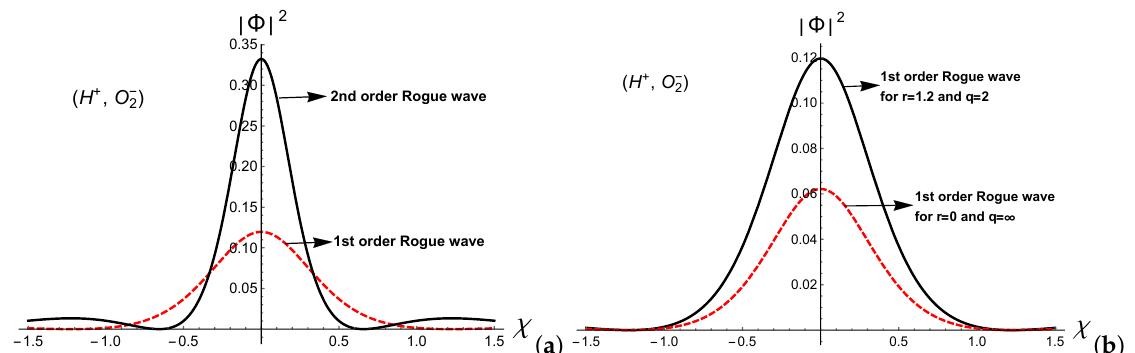
Figure 5. The amplitude of the first-and second-order IARWs with r = 1.2 and q = 2 ( a ) and the first-order IARWs amplitude obtained by non-Maxwellian ( r , q ) and Maxwellian distributed for both electrons and positrons ( r = 0, and q −→ ∞ ) ( b ) versus χ (where ζ , η and τ are equal to zero) for ( H + , O − and ω ci =